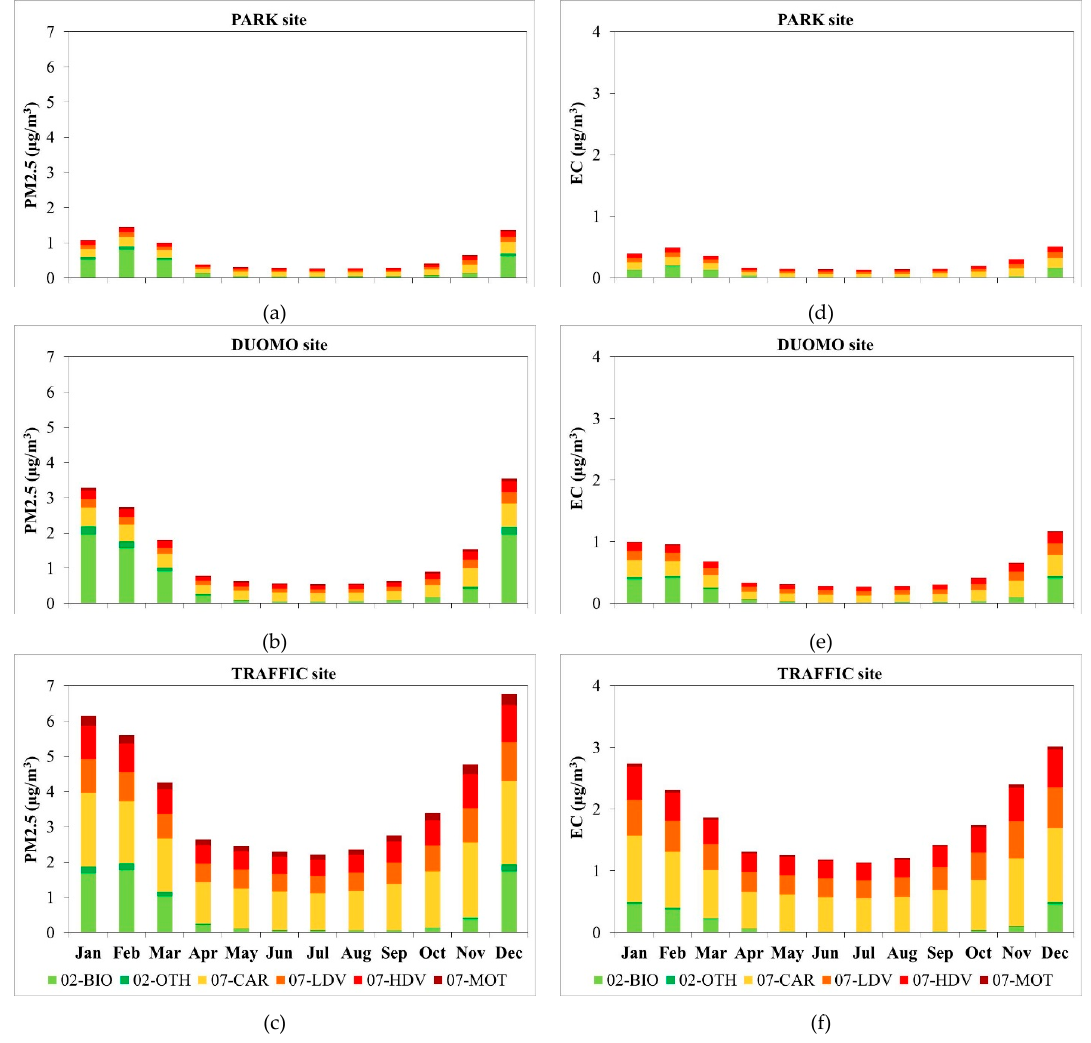
Figure 3. Monthly contributions of C&R combustion and road tra ffi c emissions from the LOCAL area to primary PM2.5 (left column: ( a ) PARK site; ( b ) DUOMO site; ( c ) TRAFFIC site) and EC (right column: ( d ) PARK site; ( e ) DUOMO site; ( f ) TRAFFIC site) ambient levels at the three urban receptors for